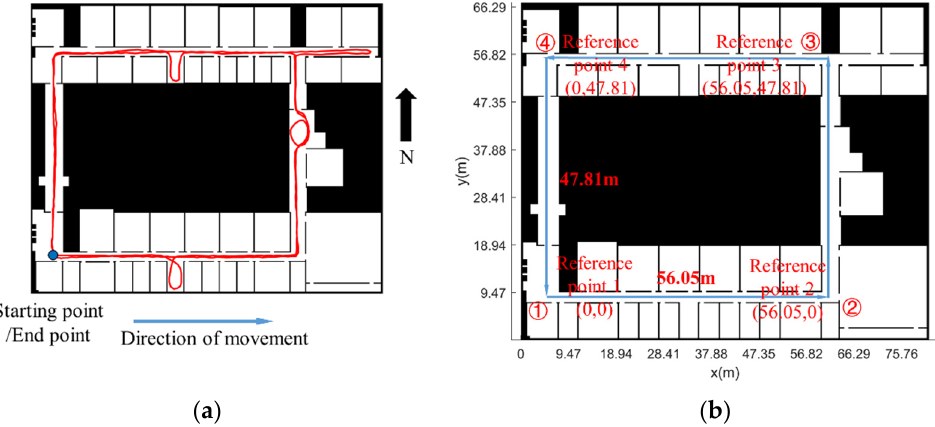
Figure 6. Simulation trace and coordinates of reference point. ( a ) Simulation trace. ( b ) Schematic diagram of the coordinates of the reference point.